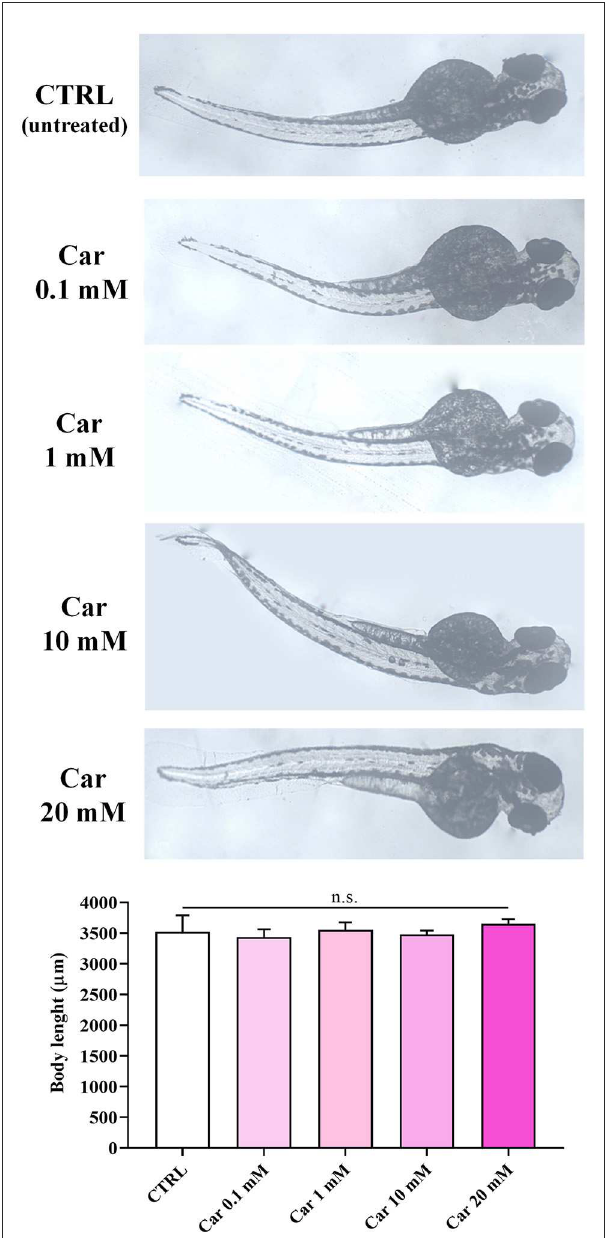
FIGURE3 Body length ( µ m) of unexposed larvae and larvae exposed to increasing concentrations of carnosine (0.1, 1, 10, and 20mM). SD is represented by vertical bars. Car, carnosine; n.s., not significant.